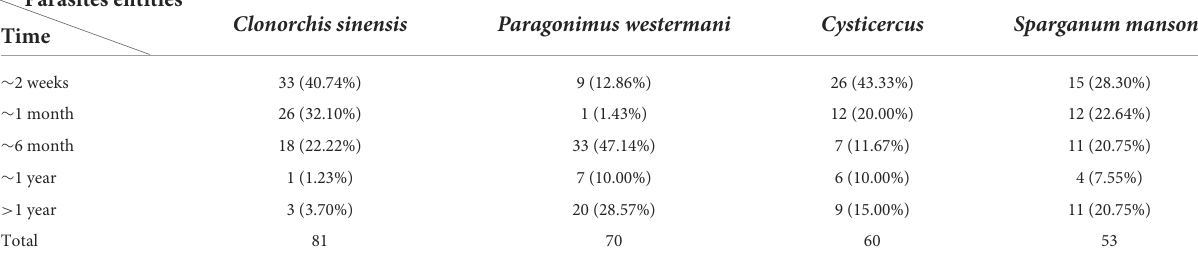
TABLE 5 Periods from onset to diagnosis among Clonorchis sinensis , Paragonimus westermani , Cysticercus and Sparganum mansoni . TimeParasites entities Clonorchis sinensis Paragonimus westermani Cysticercus Sparganum